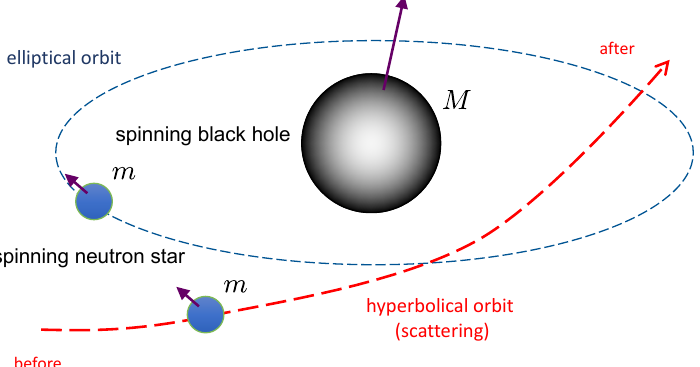
Figure 1. An illustration of an extreme-mass-ratio system consisting of spinning neutron star, of mass m , in an elliptic or a hyperbolic orbit around a spinning massive black hole, of mass M . The spin axes of the neutron star and the black hole are represented by the purple